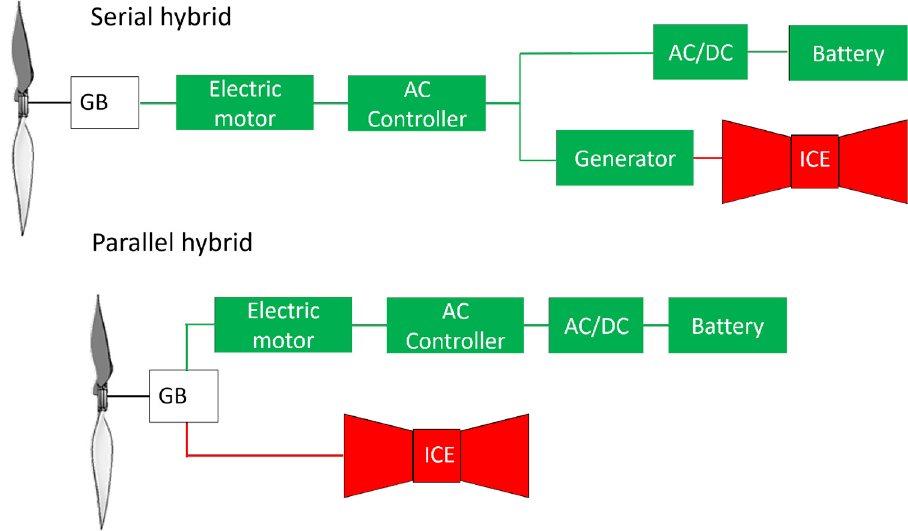
Fig. 2. Serial and parallel hybrid architecture.